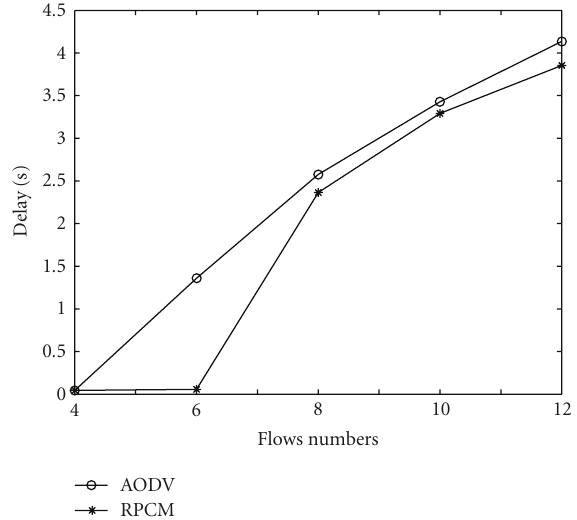
Figure 10: Performance of AODV and RPCM in terms of delay, when ρ = 4(nodes / m 2 ).